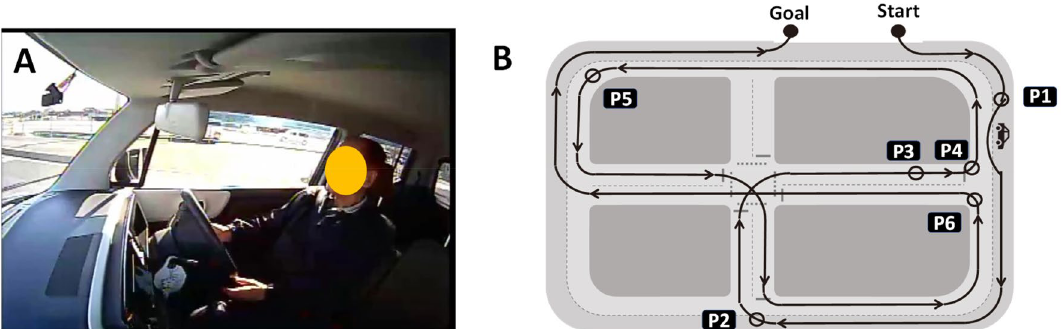
Figure 1. Driving a vehicle on a closed-circuit course. ( a ) Driver’s appearance as seen from the passenger seat. ( b ) Map of the closed-circuit course with six rating points. P1, changing lanes while driving straight; P2, turning right at an intersection; P3, straight course; P4, turning left at an intersection with a stop sign; P5, large curve with poor visibility; P6, turning left at an intersection. The corresponding author owns the copyright of the